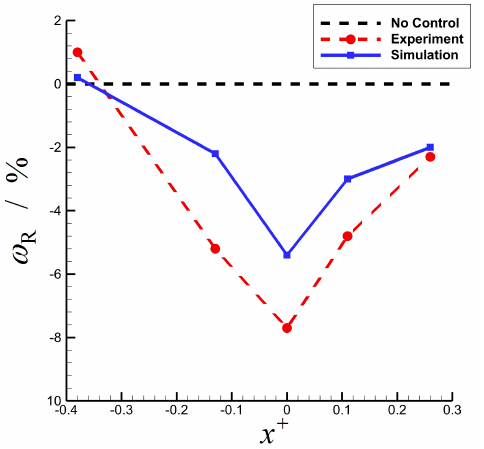
ω Figure 4. Relative total pressure loss coefficient ( ω R ) of the curved diffuser versus reduced position ) of the curved diffuser versus reduced position Figure 4. Relative total pressure loss coefficient ( R